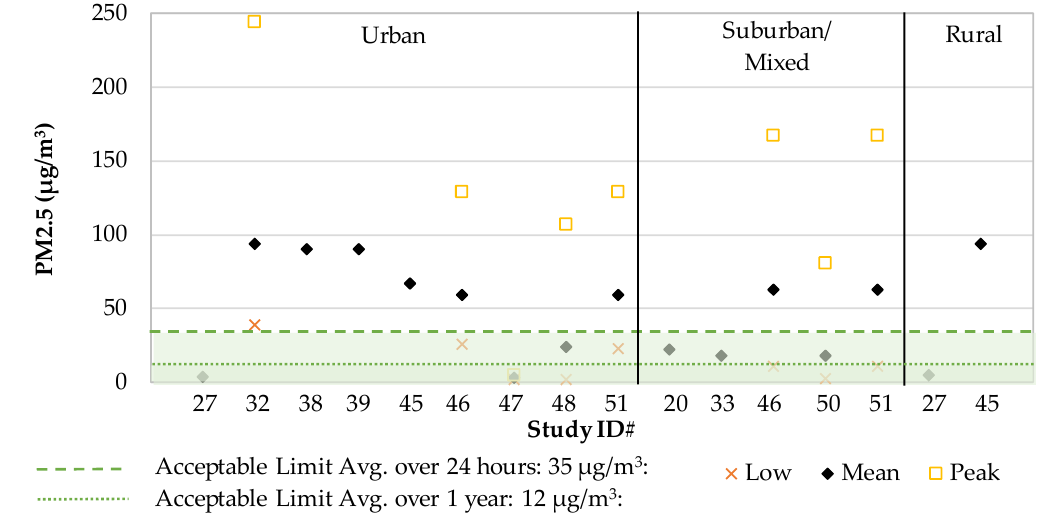
Figure 2. Low, Mean, and Peak PM2.5 of the Selected Studies by Environment Type.